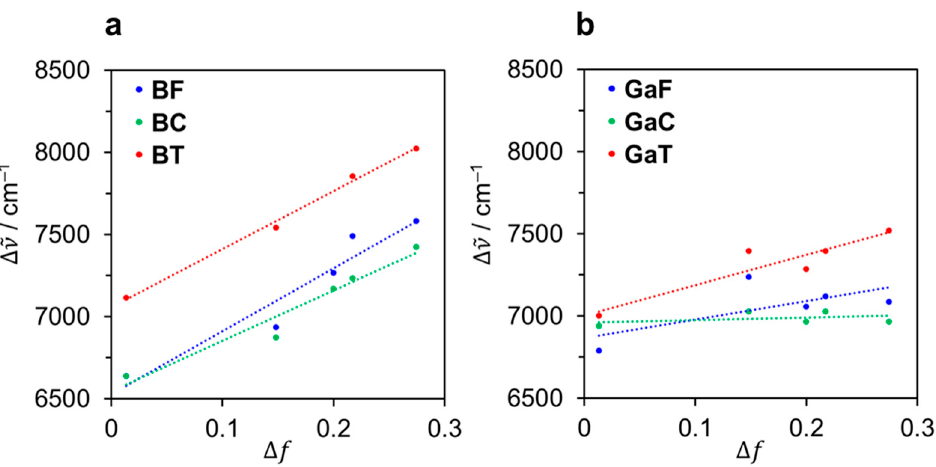
Figure 2. Lippert–Mataga plots for ( a ) boron and ( b ) gallium polymers. Solvents and ∆ f : toluene, 0.0132; chloroform, 0.148; ethyl acetate, 0.200; dichloromethane, 0.217; dimethylformamide, 0.274.